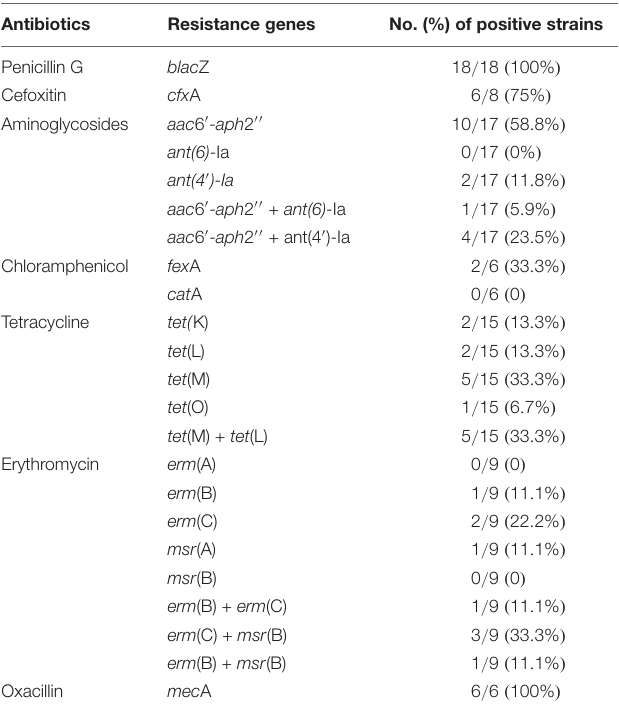
TABLE 3 | Distribution of antibiotic-resistance genes among resistant Staphylococcus